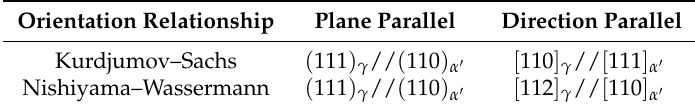
Table 2. Kurdjumov–Sachs and Nishiyama–Wassermann orientation relationships for the transformation from a parent austenite grain into the corresponding martensitic variants [1,6,31].